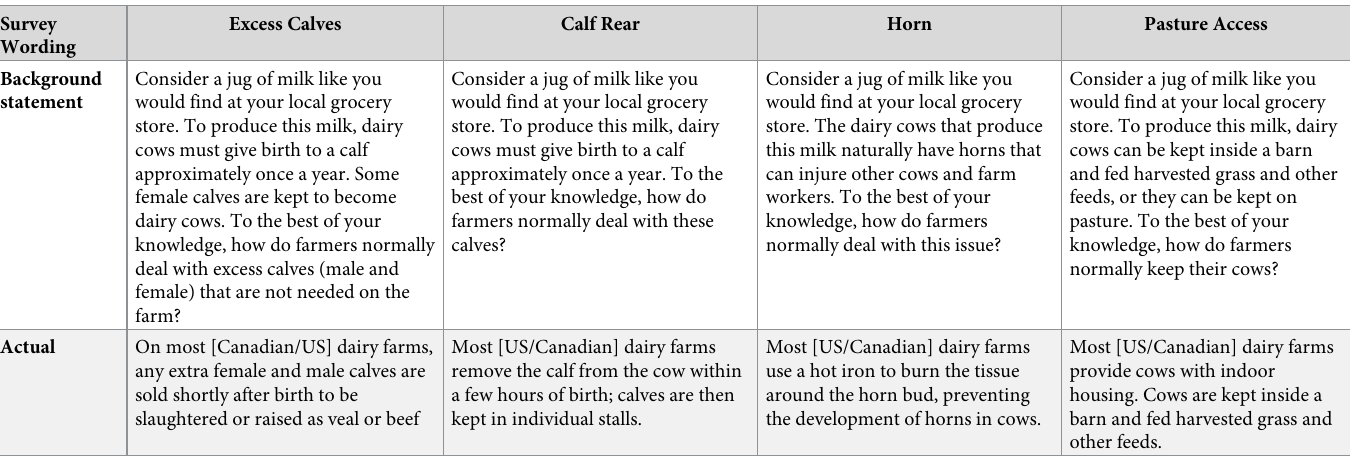
Table 2. Background information given to participants for each scenario of the survey. Survey